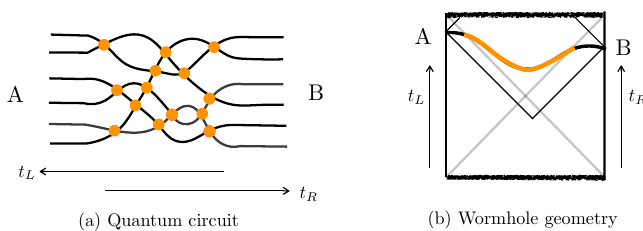
Figure 4 . Left Panel: a unitary quantum circuit with local interactions which becomes longer when t L or t R is increased. Right Panel: an extremal surface in a Schwarzschild AdS black hole connecting t L on the left and t R on the right. The part of the surface inside the black hole (marked in yellow) increases as t L or t R is increased, and is believed to be described by a quantum